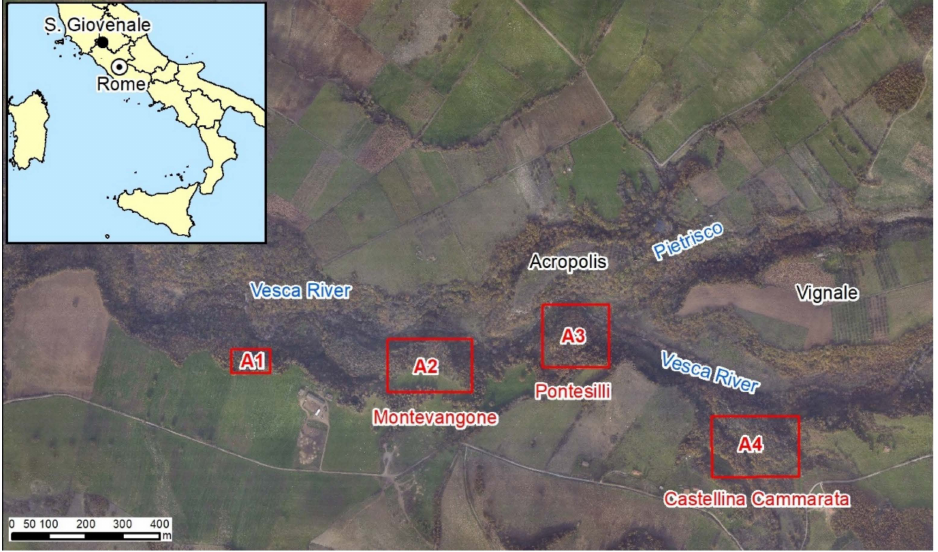
Figure 1. The S. Giovenale study area, with the four subset areas and the main